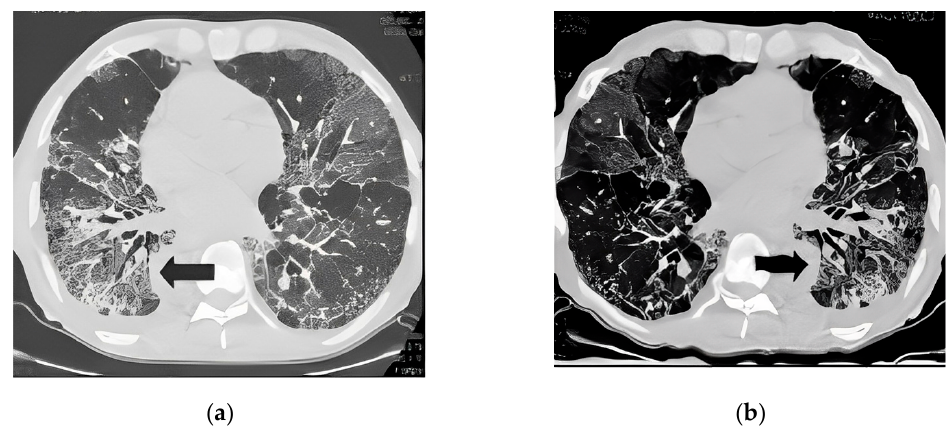
Figure 1. An example of applying an augmentation method. ( a ) The original image; ( b ) After applying an augmentation method.